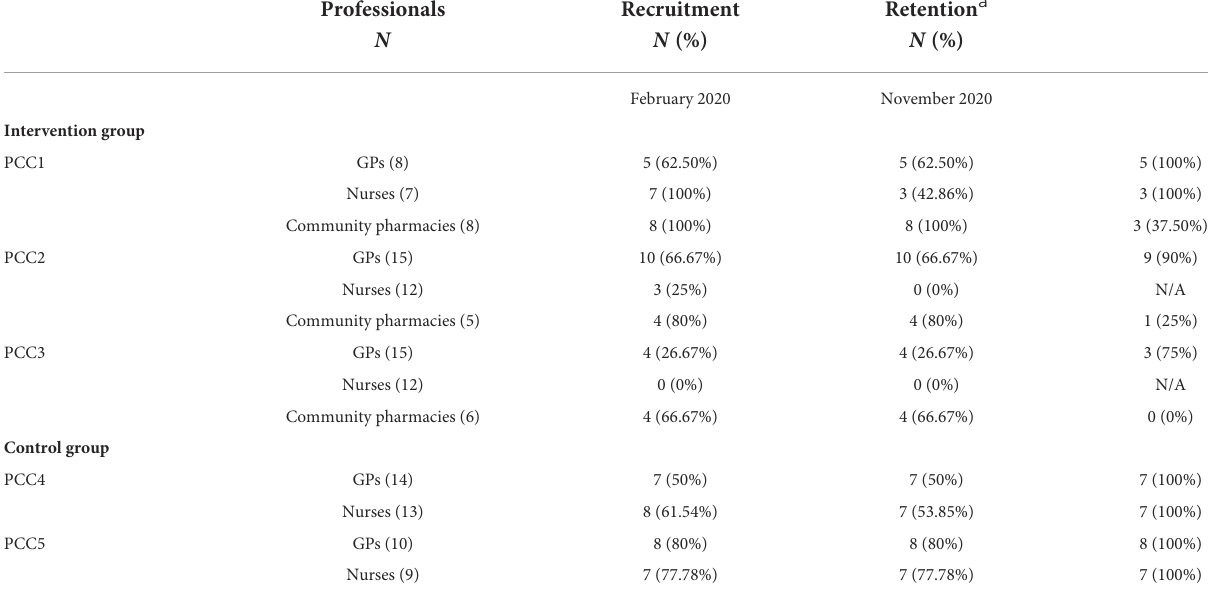
TABLE 6 Professional recruitment and retention rates.